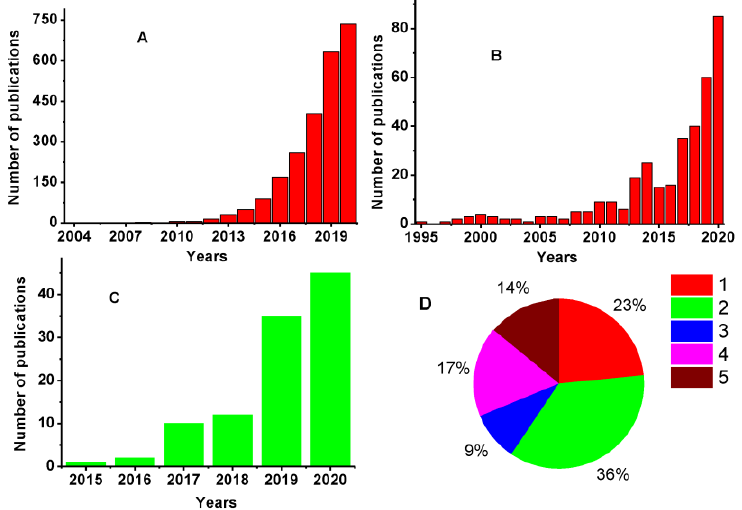
Figure 4. Analysis of the bibliography devoted to the application of aptamers in electrochemical sensors and biosensors performed with the Web of Science database. ( A ) ‘MOF’ and ‘electrochemical’ search; ( B ) ‘MOF’ and ‘aptasensor’ search; ( C ) ‘MOF’ and ‘electrochemical aptasensor’ search; ( D ) pie chart describing distribution of the signal measurement modes: 1—assessment of permeability of the surface layer; 2—application of biochemical amplification approaches; 3—sandwich assay; 4—measurement of intrinsic redox activity of the MOFs; 5—application of diffusionally free redox indicators.